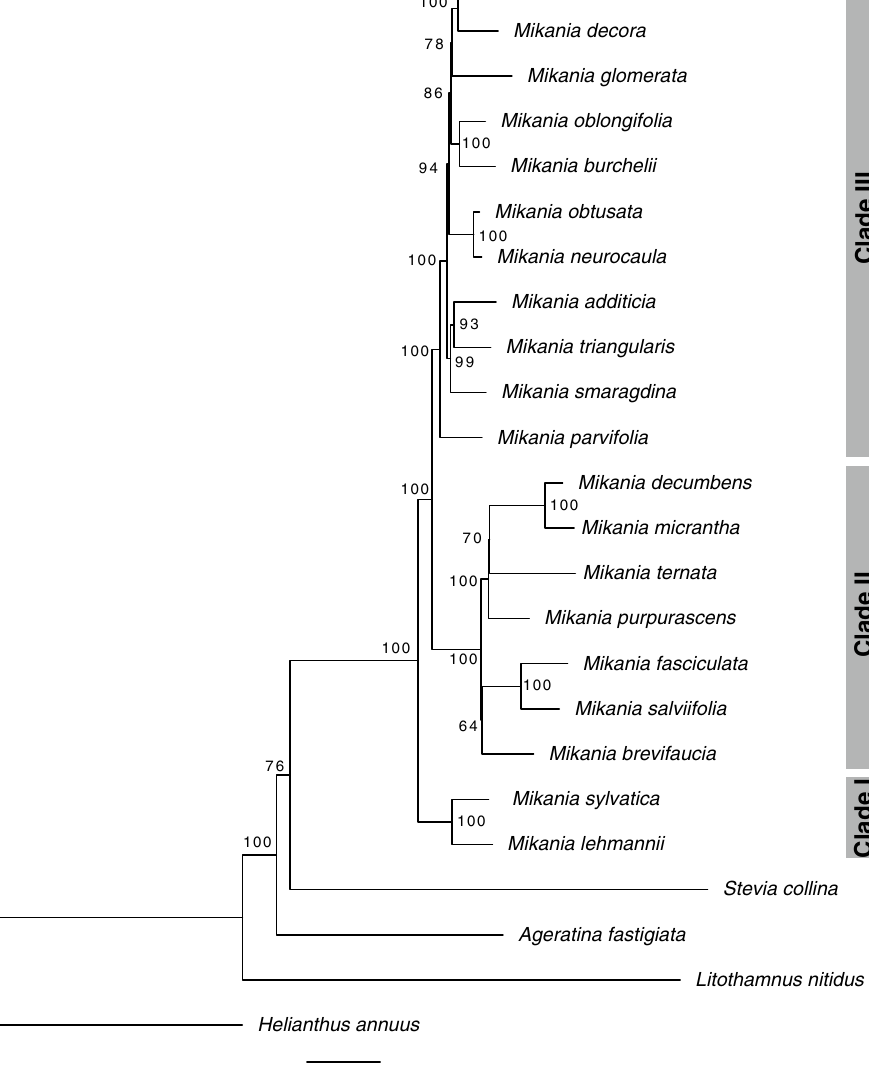
Figure 3. Representative topology of phylogenetic relationships in Mikania , showing three main clades. This tree represents the concatenated maximum likelihood analysis conducted with the whole plastome sequence with one of the IRs removed. Bootstrap support values shown in each